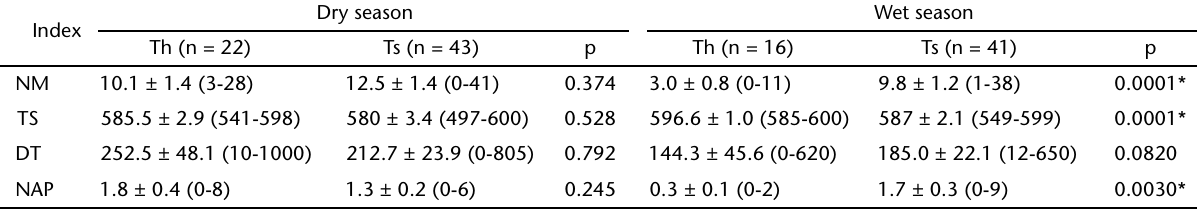
Table I. Seasonal comparisons for measures of foraging intensity during ten-minute focal animal observations of T. hispidus (Th) and T. semitaeniatus (Ts) at the Ecological Station of the Seridó, Brazil. (NM) Number of moves, (TS) time spent stationary (seconds), (DT) distance traveled (cm), (NAP) number of attacks on preys. Data are represented as mean ± 1 SE (range) and p values are based on the Mann-Whitney U test. Significant differences are highlighted with an